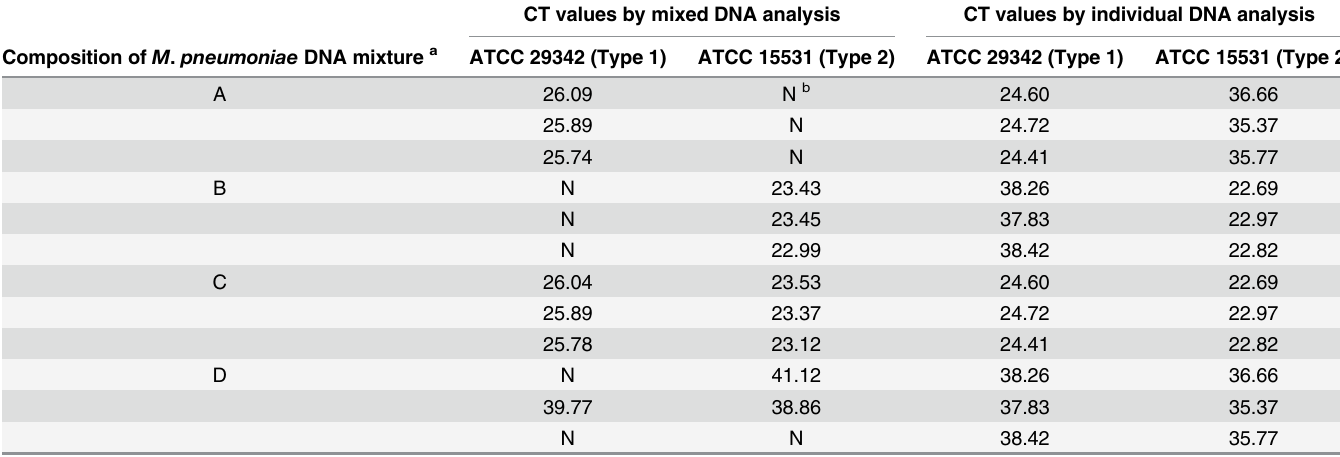
Table 3. CT values of 4 mixtures of M . pneumoniae type 1 and type 2 DNA analyzed by duplex real-time PCR. CT values by mixed DNA analysis CT values by individual DNA